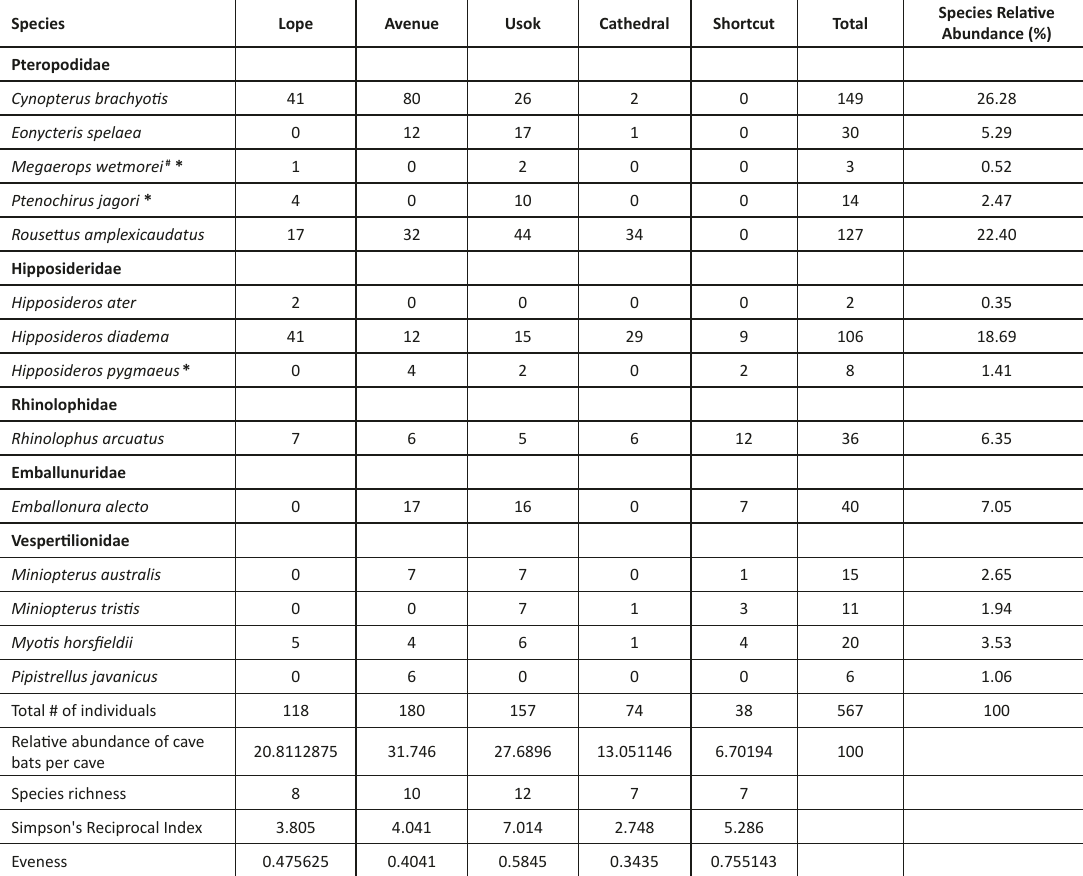
Table 1. Taxonomic list of cave-dwelling bat species identified from Pisan caves, Kabacan, northern Cotabato, in South central Mindanao.